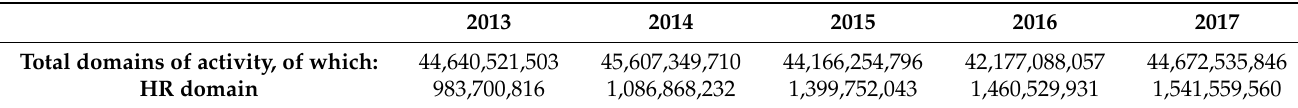
Table 1. Turnover of active enterprises in Constanta County, from 2013 to 2017 (RON, 1 USD = 4.04 RON). Source: TEMPO- Online database (http://statistici.insse.ro:8077/tempo-online/#/pages/tables/insse-table) accessed on 10 June 2021.